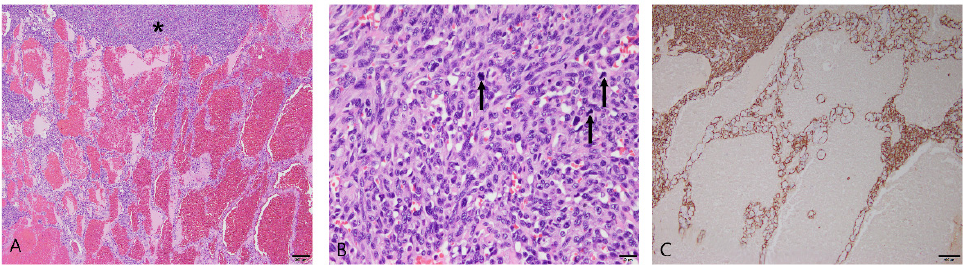
Figure 3. Splenic hemangiosarcoma in the spleen of a dog. ( A ) Irregular vascular and trabecular structures filled the splenic parenchyma. Solid areas with no vascular space were also observed (asterisk). Hematoxylin and eosin (H&E) at 40× magnification. Scale bar = 200 µm. ( B ) The neoplastic endothelial cells were plump, with anaplastic features. Mitotic figures were seen (arrows). H&E at 400× magnification. Scale bar = 20 µm. ( C ) Immunohistochemical staining for CD31 with Mayer’s hematoxylin counterstain. CD31 was strongly expressed in the cell membrane and cytoplasm of neoplastic endothelial cells. 100× magnification. Scale bar = 100 µm.